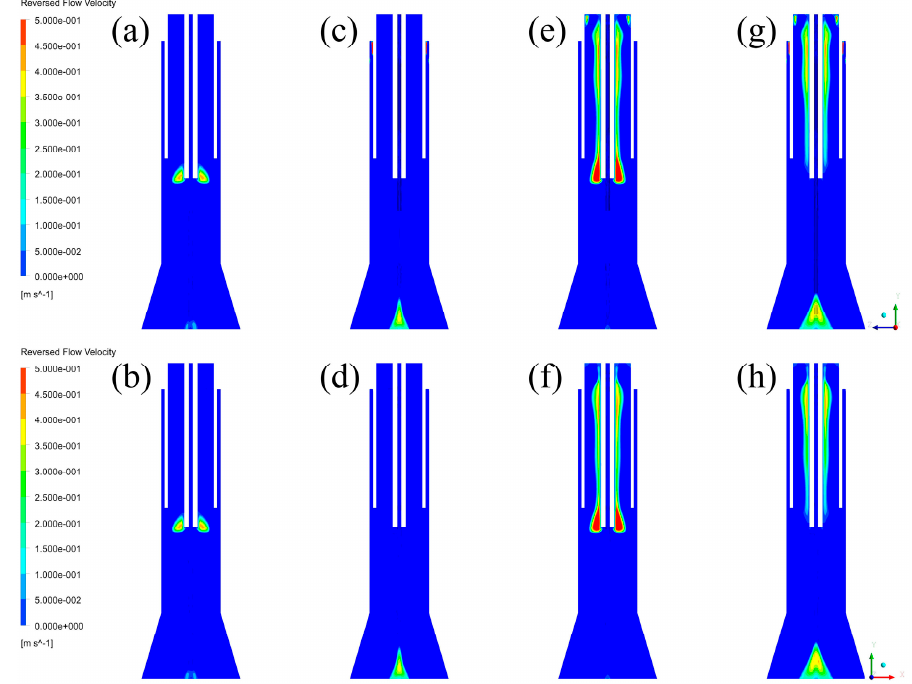
Figure 5. Reversed flow velocity fields: ( a ) Case A in YZ plane, ( b ) Case A in XZ plane, ( c ) Case B in YZ plane, ( d ) Case B in XZ plane, ( e ) Case C in YZ plane, ( f ) Case C in XZ plane, ( g ) Case D in YZ plane, ( h ) Case D in XZ plane.